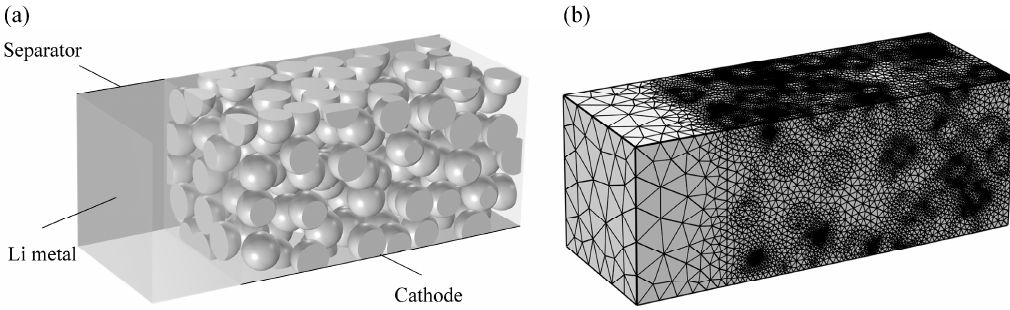
Figure 1. ( a ) The homogeneous electrode used in the study; ( b ) the corresponding unstructured mesh.